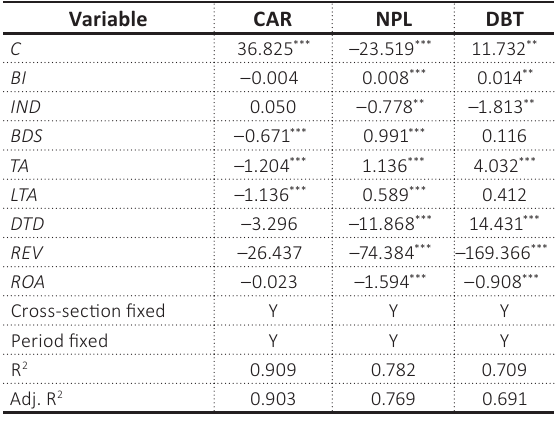
Table 3. The linear effect of board gender